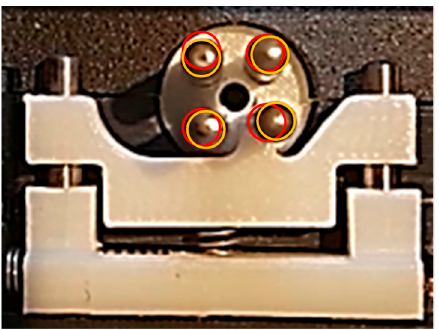
Figure 16. Clarification of the different positions of the pins while resetting; red: end position/posi- tion, as it should be; yellow: actual position as it is taken during resetting. However, professional manufacturing of the actuator with low tolerances can eliminate these fluctuations. To visualize this, the wire was removed and the shaft was turned by hand. In doing so, the stroke of the actuator was recorded again. The results are shown in Figure 17.